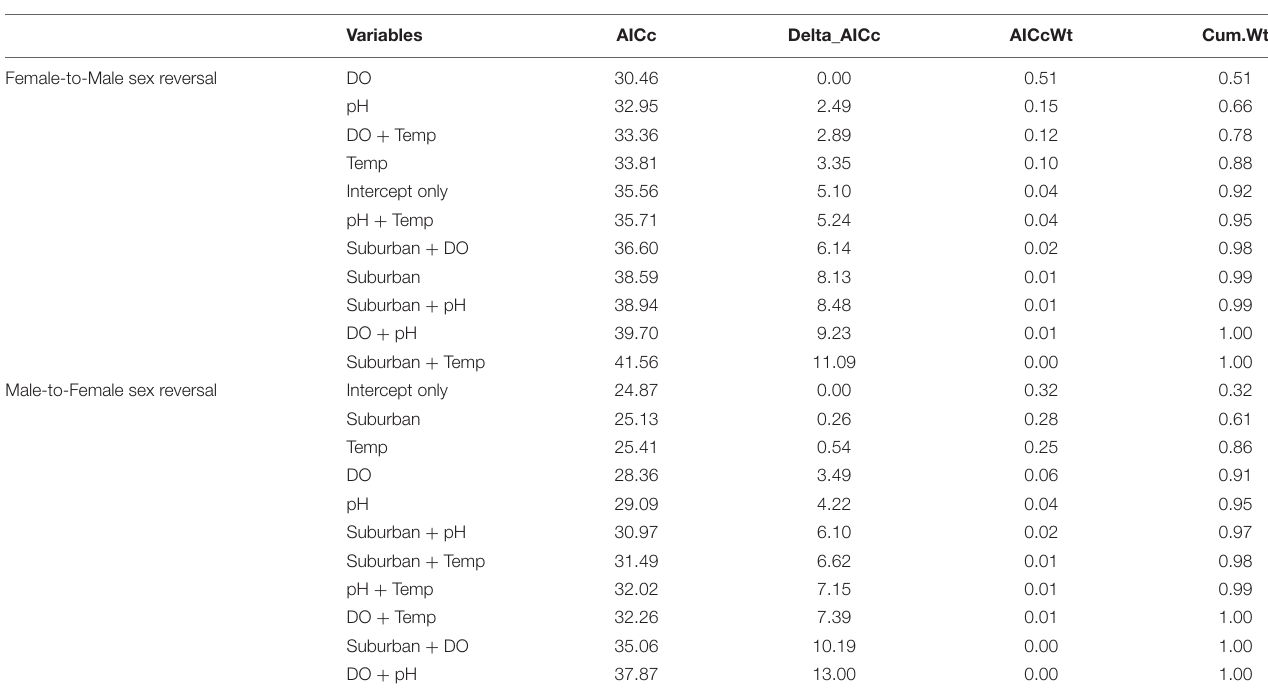
FIGURE 4 | Female-to-male sex reversal rates are highest in metamorphosing green frog ( Rana clamitans ) tadpoles developing in ponds with lower dissolved oxygen (A) , more acidic pH (B) , and cooler water temperatures (C) . TABLE 3 | Model ranking for environmental predictors of sex